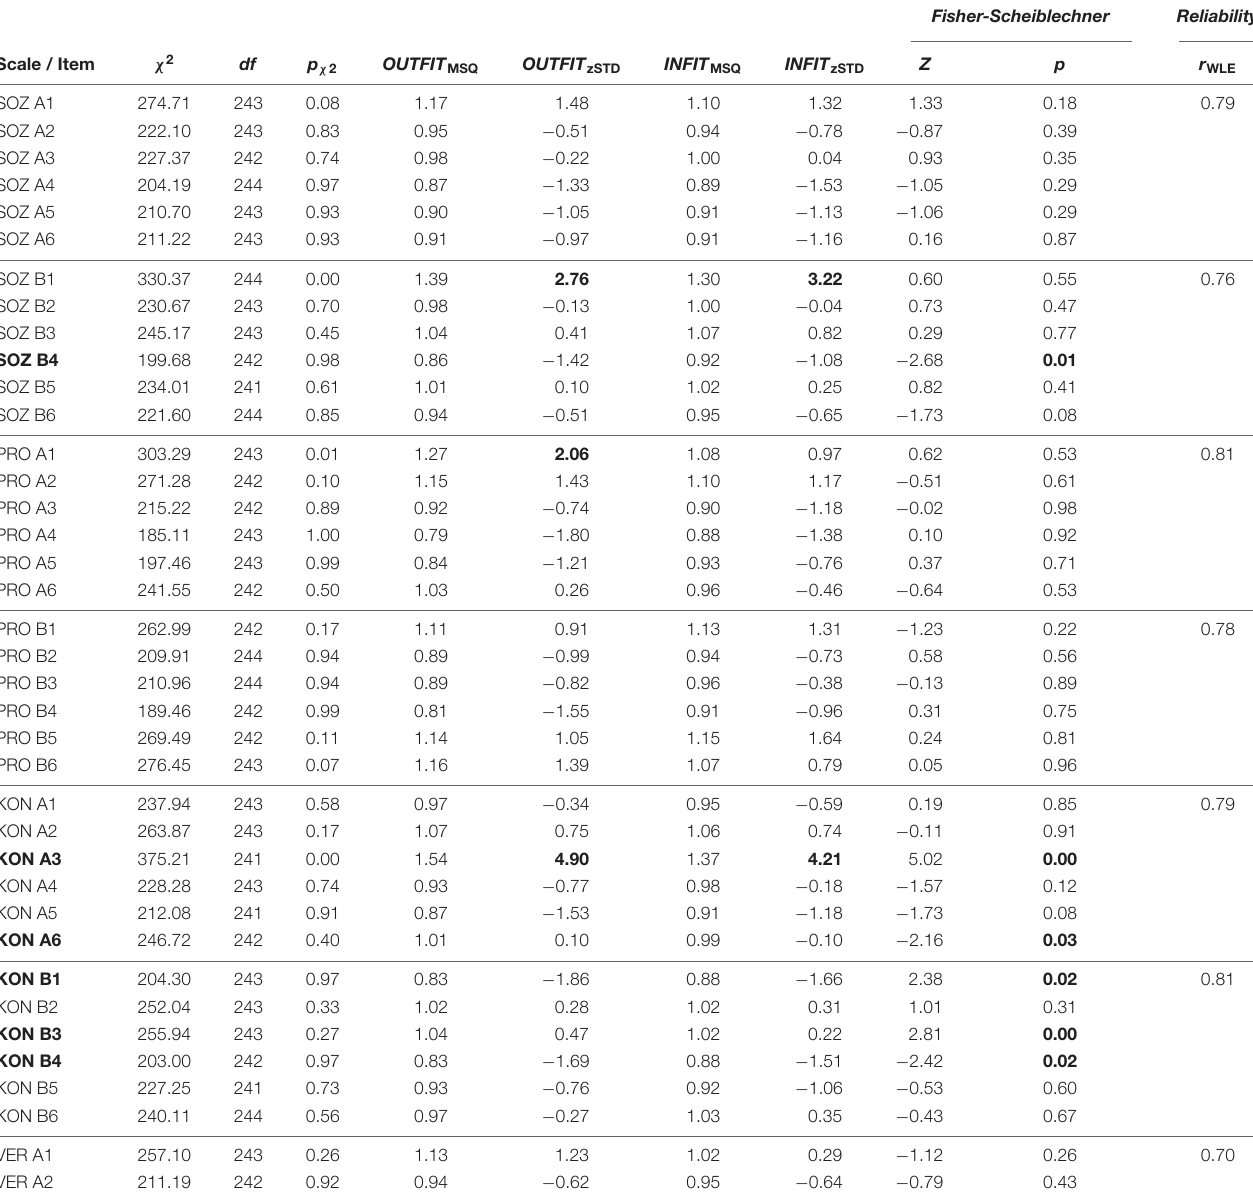
TABLE 3 | Coefficients for Fisher-Scheiblechner Z -Test, local and global fit indices for one dimensional scaling differenciated by situations.